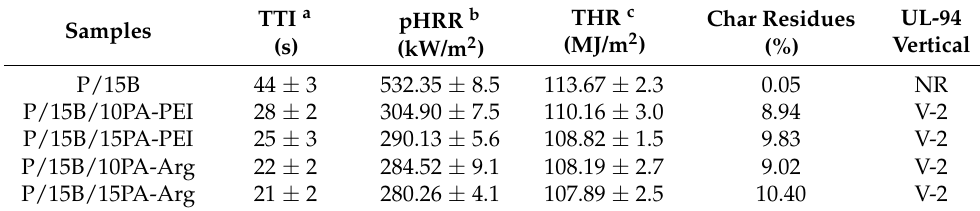
Figure 7. ( a ) HRR and ( b ) THR curves of P/15B-based biocomposites. Table 5. The combustion data of P/15B-based bicomposites.